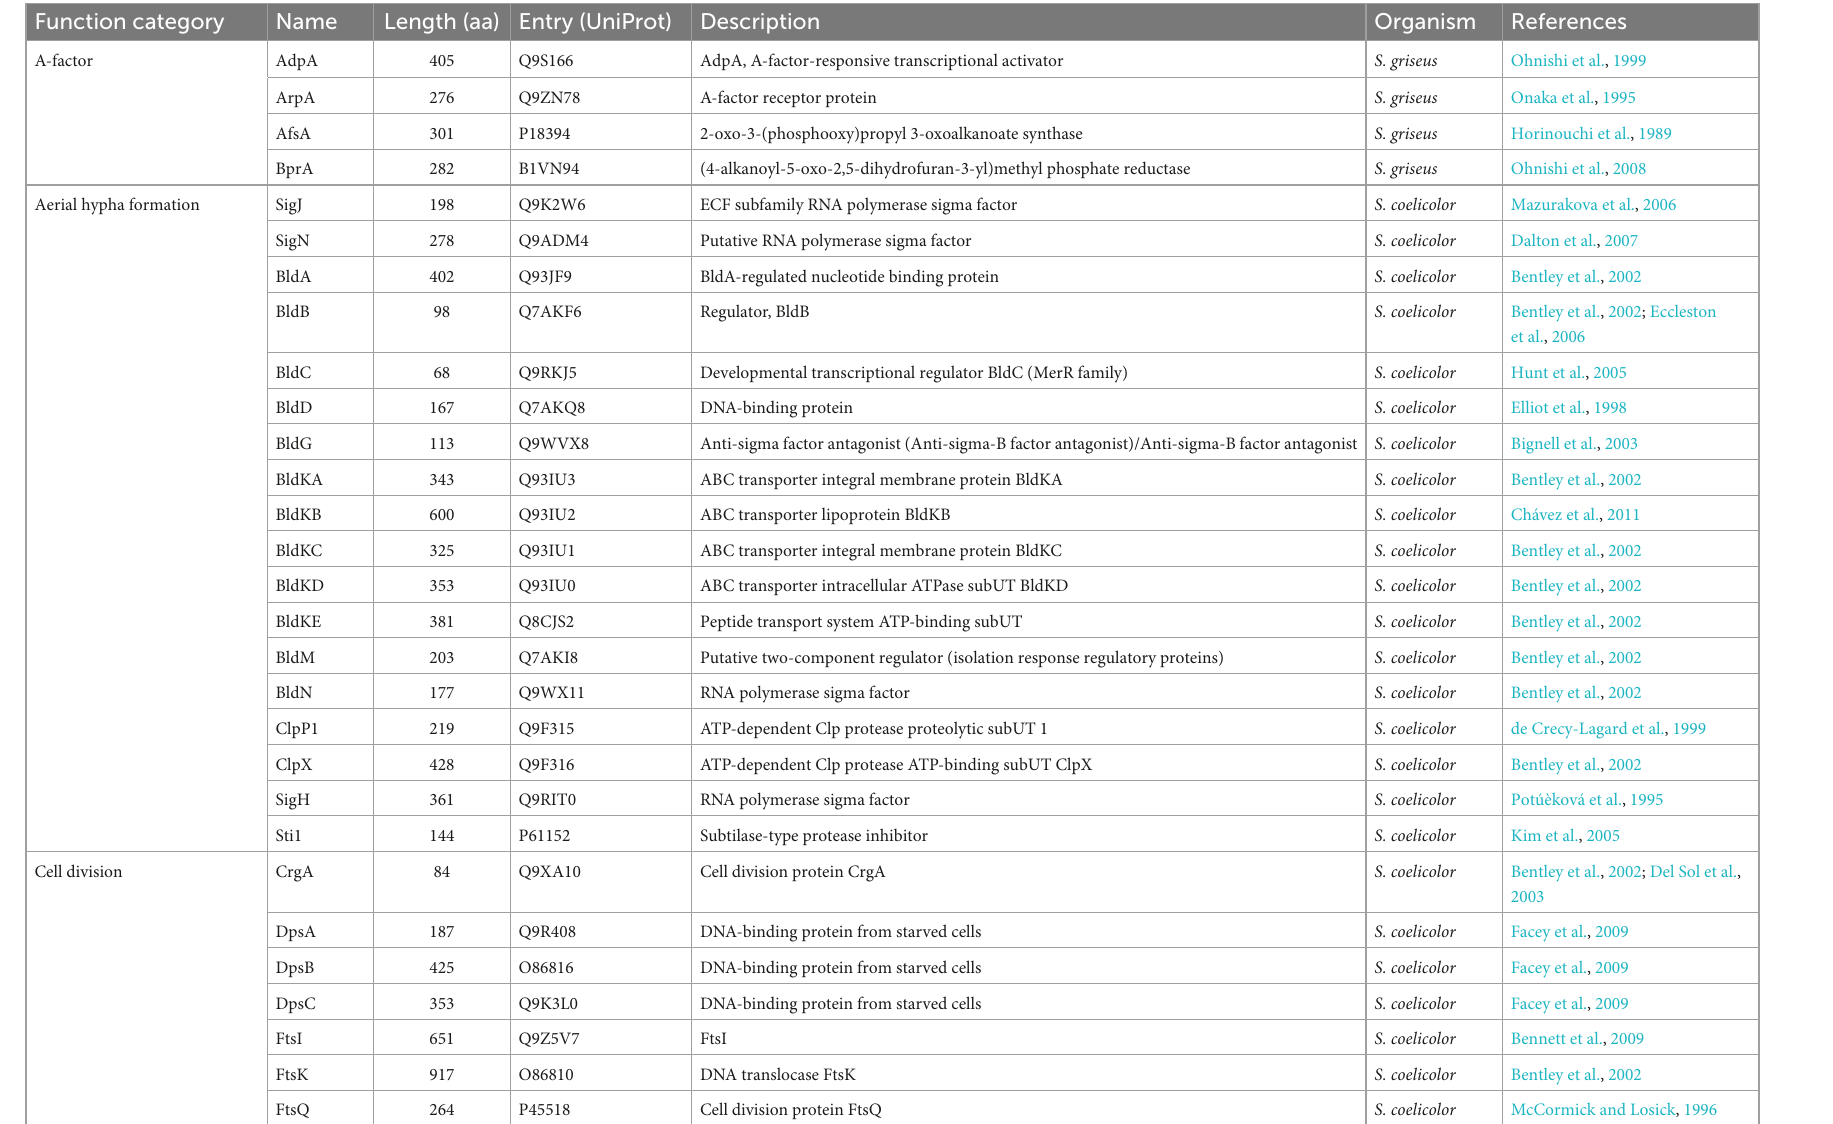
TABLE 1 The detailed information of development-related proteins in the genus